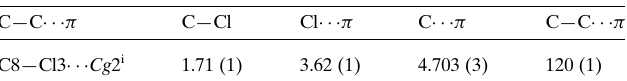
Table 2 C—Cl (cid:3)(cid:3)(cid:3) (cid:2) geometry (A˚ , (cid:2) ) for (II). Cg 2 is the centroid of the C9–C14 ring.